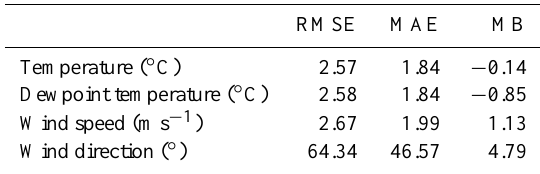
Table 1. Summary of annual mean errors of the meteorological model WRF for 2-m temperature, 2-m dew point temperature, 10-